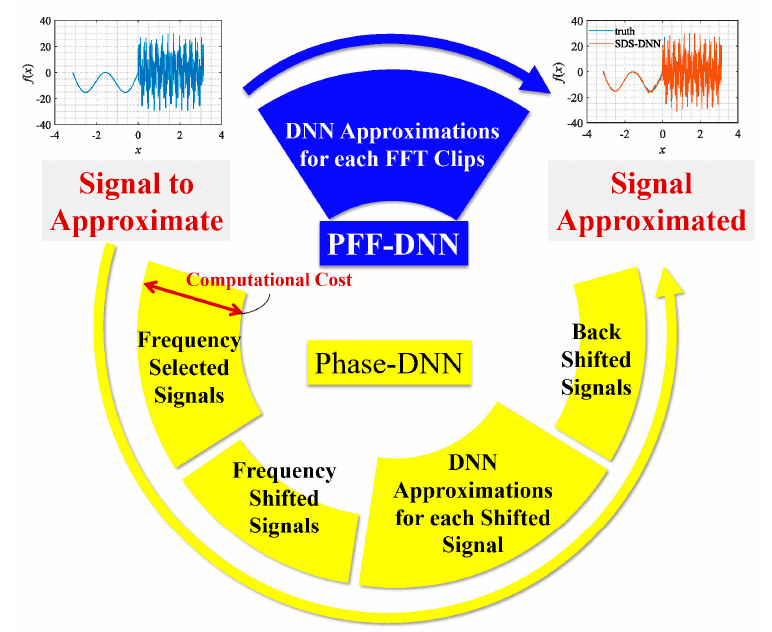
Figure 2. Flowchart of the PhaseDNN algorithm and the proposed PFF-DNN method.